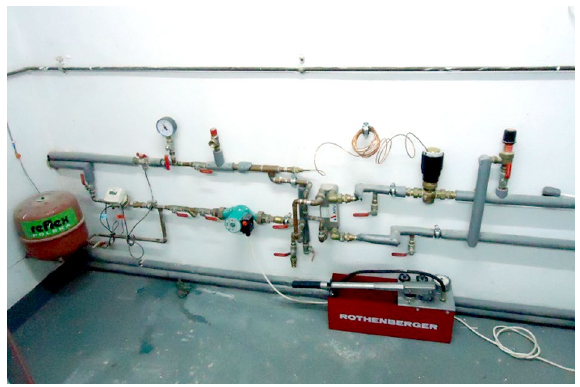
Fig. 4. Heat substation for heating surface at an open space